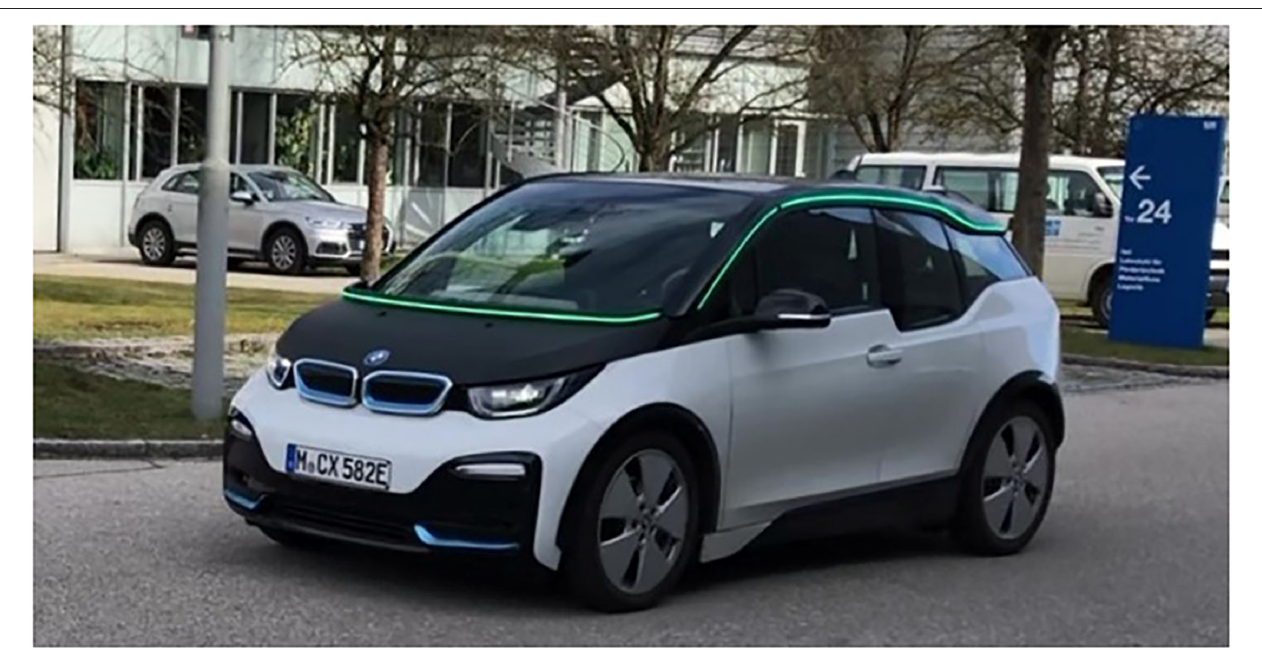
FIGURE 2 | eHMI concept intention-based light-band communicating “I’m letting you go